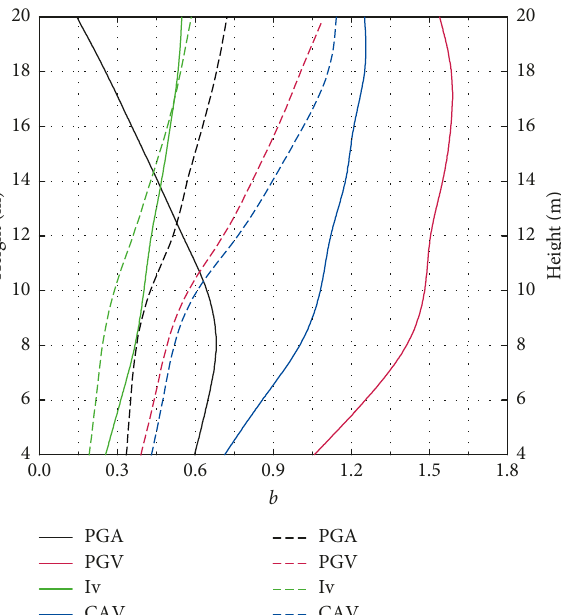
Figure 10: Practicality comparison of IMs under pulse-like and far-field ground motions. The solid lines and dashed lines refer to the cases of pulse-like and far-field ground motions,